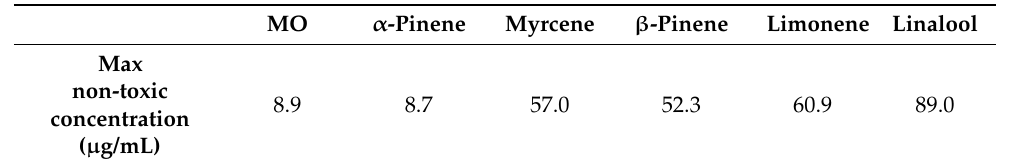
Table 1. Maximum non-toxic concentrations of MO or its major constituents in RAW264.7 cells as determined by the SRB